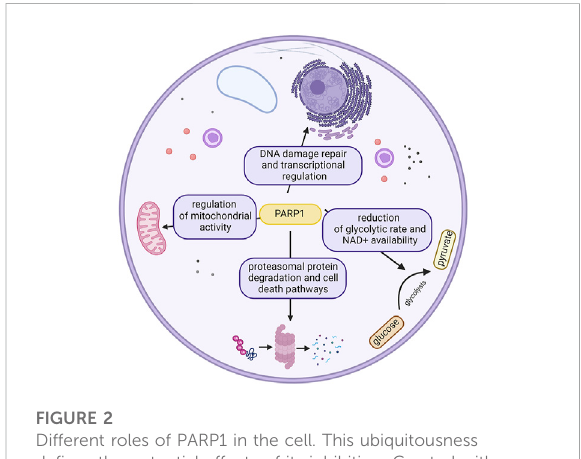
FIGURE 2 Different roles of PARP1 in the cell. This ubiquitousness de fi nes the potential effects of its inhibition. Created with